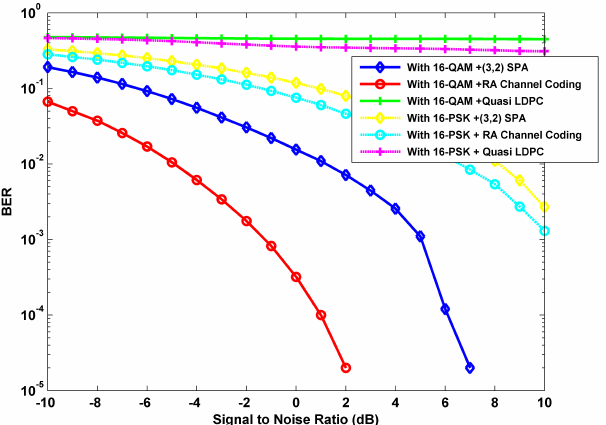
Figure 8. BER performance of the considered system with utilization of various channel coding, higher − order digital modulation, and ZF signal detection techniques for user 4.